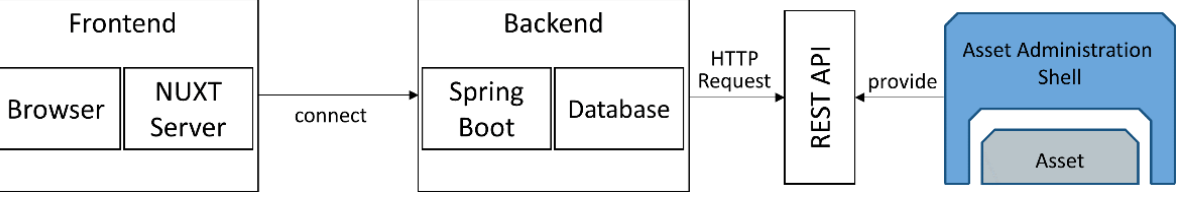
Figure 11. High-level architecture of the FA 3 ST manager.